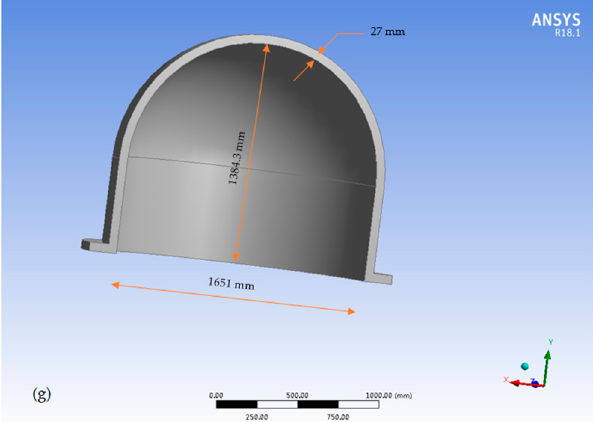
Figure 2. ( a ) Eigenvalue of buckling; ( b ) top view showing buckling; ( c ) values of the Tsai-Wu safety factor; ( d ) Values of the Tsai-Hill safety factor; ( e ) values of total deformation; ( f ) values of von Mises stress; ( g ) dimensions of the best radome configuration.